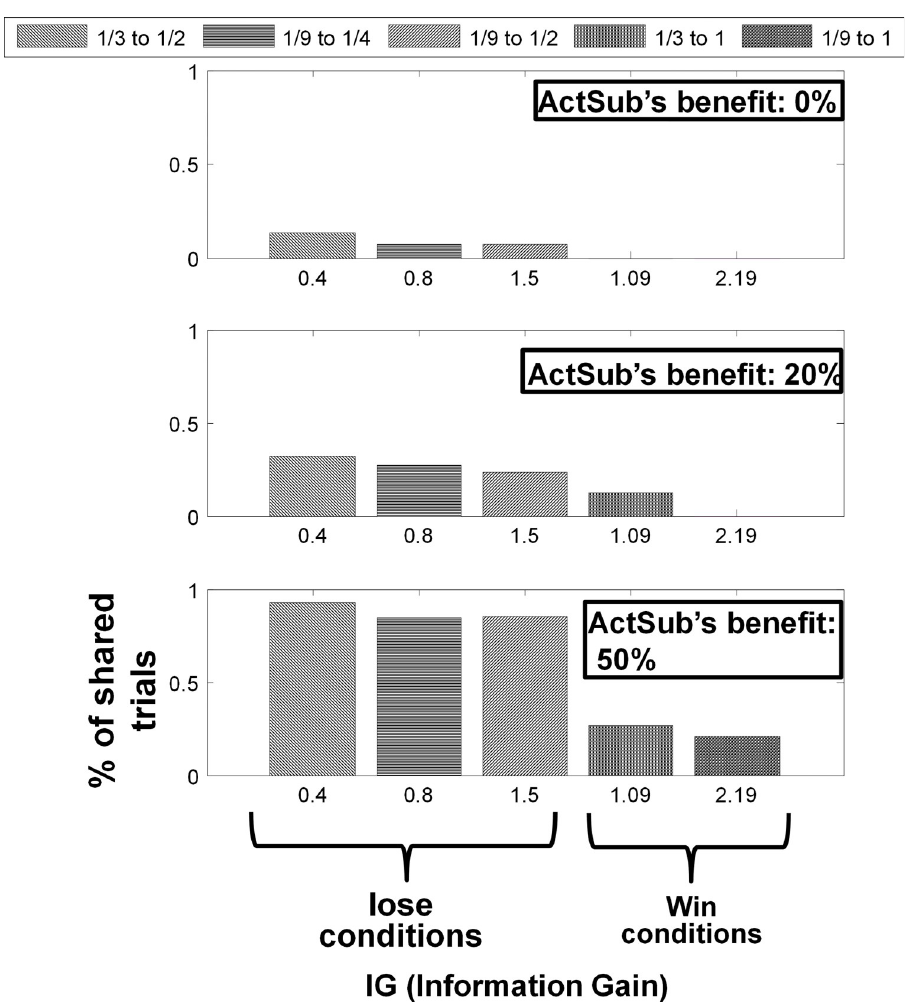
Fig 2. The average frequency of sharing responses is shown with details in the pool of data. We had three different benefit percentages for ActSub (0%, 20%, and 50%), and for each benefit percentage, we had five different IGs. Two of these IGs are win conditions, and 3 of them are the conditions in which the ActSub has failed. The IGs are sorted for the win and lose conditions separately. Standard errors of sharing frequencies among the subjects are depicted in each of the 15